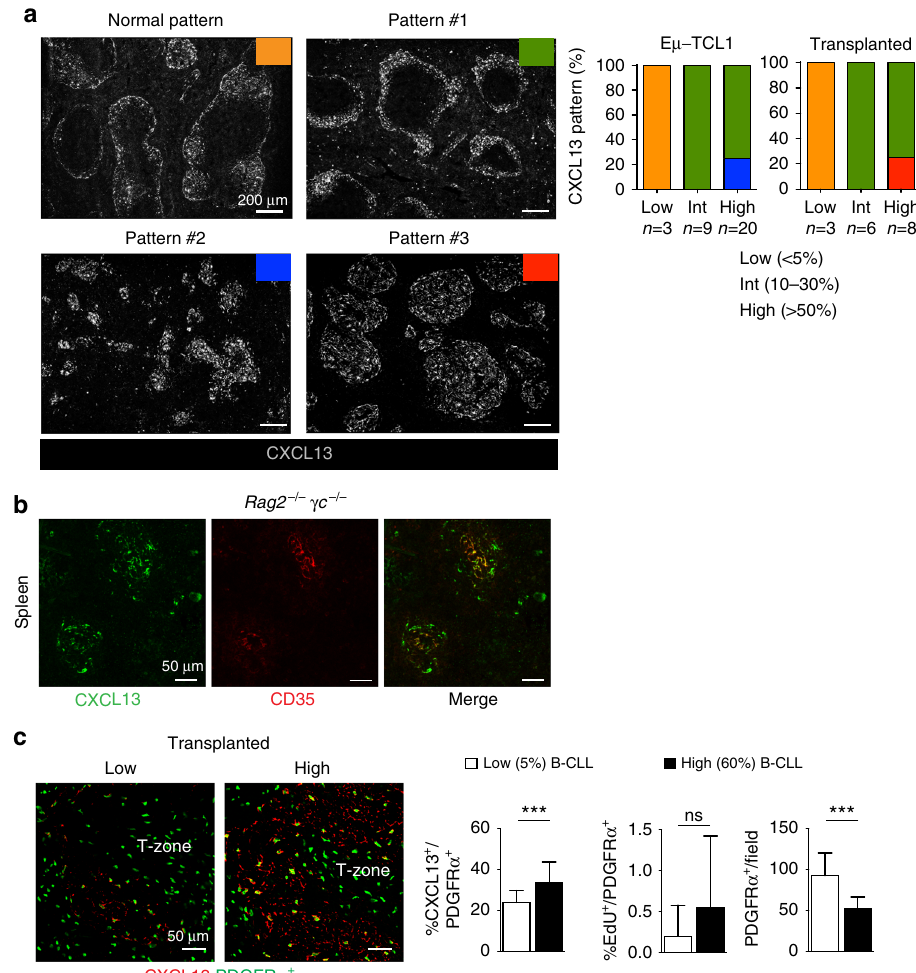
Fig. 4 Leukemia development is associated with increased CXCL13 in stromal cells. a Representative confocal mosaic images of the spleen. Tissues were isolated from mice with low (<5%), intermediate (10 – 30%), and high (>50%) leukemia in fi ltration and stained for CXCL13 (gray) to visualized follicular stromal cells. Graphs indicate the frequency of the different CXCL13 patterns (normal, #1, #2, and #3). Scale bars = 200 μ m. b Representative confocal images of spleen sections from Rag2 − / − γ c − / − mice injected with leukemic cells, and stained three-weeks after with CD35 (red) or CXCL13 (green) to visualize stromal cells. Each staining is representative of three mice analyzed. Scale bars = 50 μ m. c Representative confocal images of the spleen from Pdgfr α gfp/ + mice injected with EdU to assess proliferation at different stages of leukemia development. Tissues were stained for GFP (green) to visualize PDGFR α + cells and CXCL13 (red). Graphs represent: (i) the percentage of EdU + PDGFR α + proliferating stromal cells (middle); (ii) the number of CXCL13 + PDGFR α + stromal cells (left); and (iii) the number (density) of PDGFR α + stromal cells per fi eld (right). Each count represents the mean ± SD of cells from seven to ten fi elds analyzed for each tissue. *** p < 0.001. Scale bars = 50 μ m. Each staining is representative of one out of three to fi ve mice